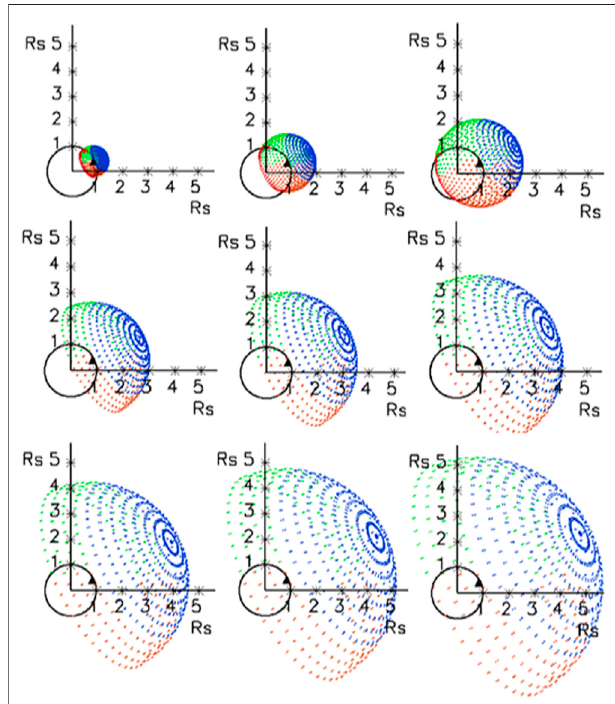
FIGURE 2 | An example S2M geometric shock surface model, including the points belonging to the spheroid “ cap ” (in blue) and “ zones ” (green and red). The footpoints on the Sun are shown in dark